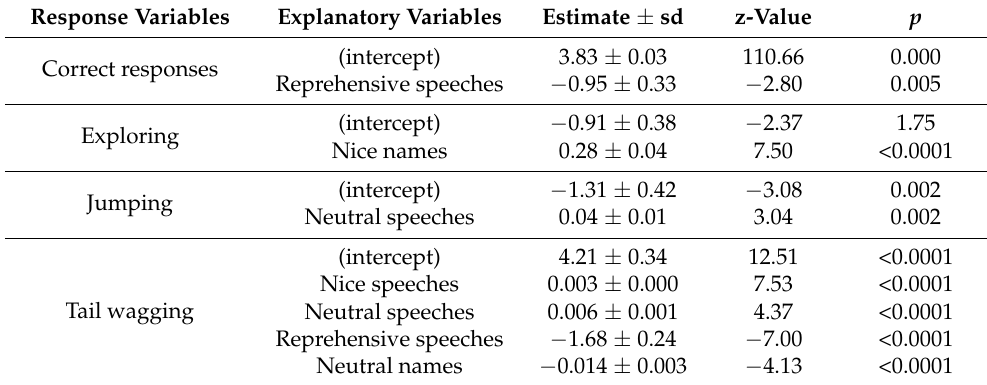
Table 5. Final Generalized Linear Mixed Models * run for dogs ( Canis familiaris ), evaluating the effects of the variables nice speeches, nice names, neutral speeches, neutral names, and reprehensive speeches on the response variables correct responses, exploring, jumping, and tail wagging.